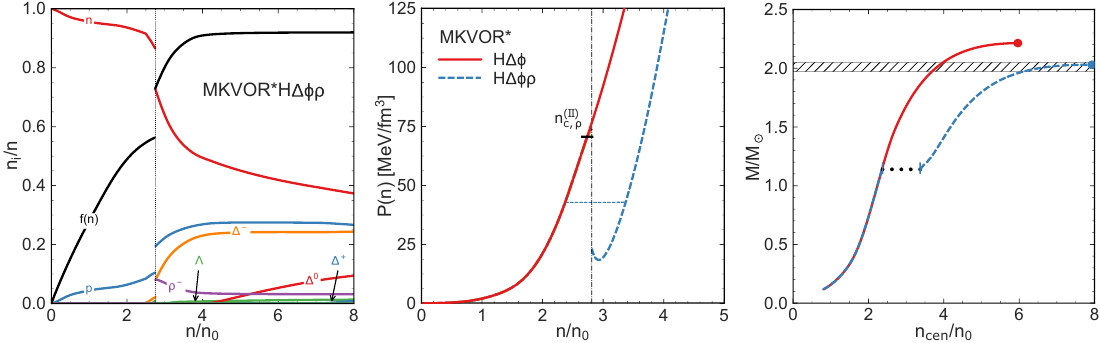
Figure 1. Left panel : Particle fractions together with the scalar field f as functions of the total baryon density n in the BEM for the MKVOR*H ∆ φρ model. Only the energetically favorable regions of the solutions’ branches are shown. Middle panel : The pressure as a function of the density for MKVOR*H ∆ φ and MKVOR*H ∆ φρ models. The short vertical dash shows the critical density for the 2nd order phase transition (PT). The vertical line in the left and middle panels denotes the density, at which the ρ -condensed phase becomes energetically more favorable than the normal one. Right panel : NS mass as a function of the central density for the same models as in the middle panel. Vertical dashes denote boundaries of the Maxwell construction region (shown by the dotted line), where no stable NS configurations exist. The horizontal stripe denotes the observational constraint M max ≥ ( 2.01 ± 0.04 ) M (cid:12) [2] and large dots denote the maximum masses for the